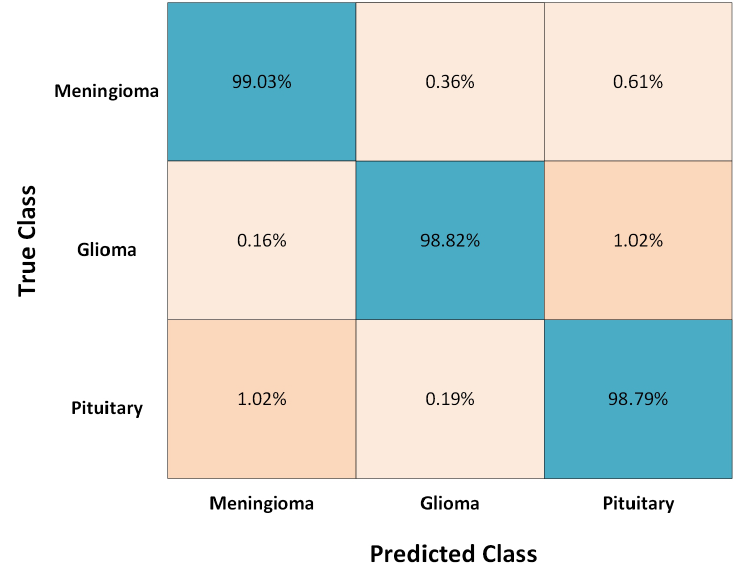
Figure 8. Receiver operating characteristic (ROC) curve of the proposed meningioma detection method.